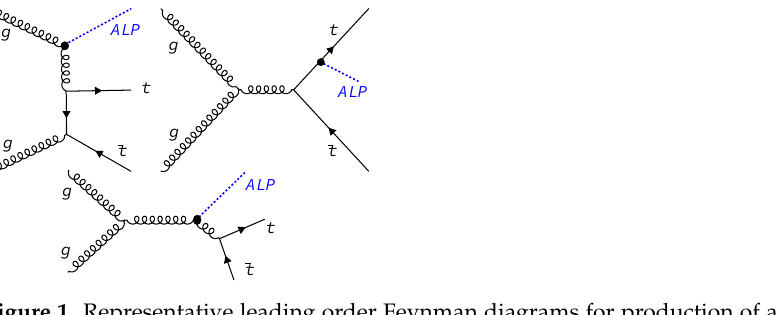
Figure 1. Representative leading order Feynman diagrams for production of a pair of top quarks with an ALP in pp